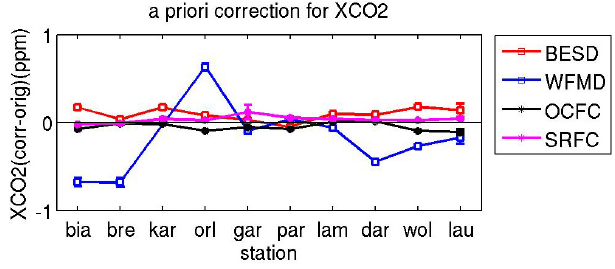
Figure 2. Mean a priori correction (XCH 4 corrected – XCH 4 orig- inal), in ppb, on the XCH 4 result, per